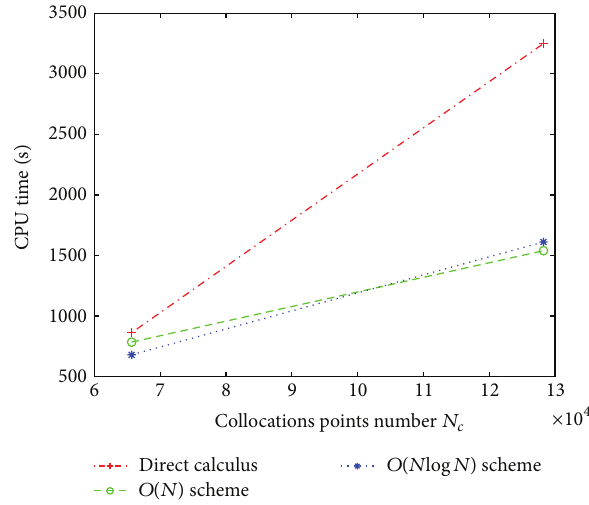
Figure 16: CPU time of the direct calculus and the two schemes 𝑂(𝑁 log 𝑁) and 𝑂(𝑁) versus the level for several values of 𝑁